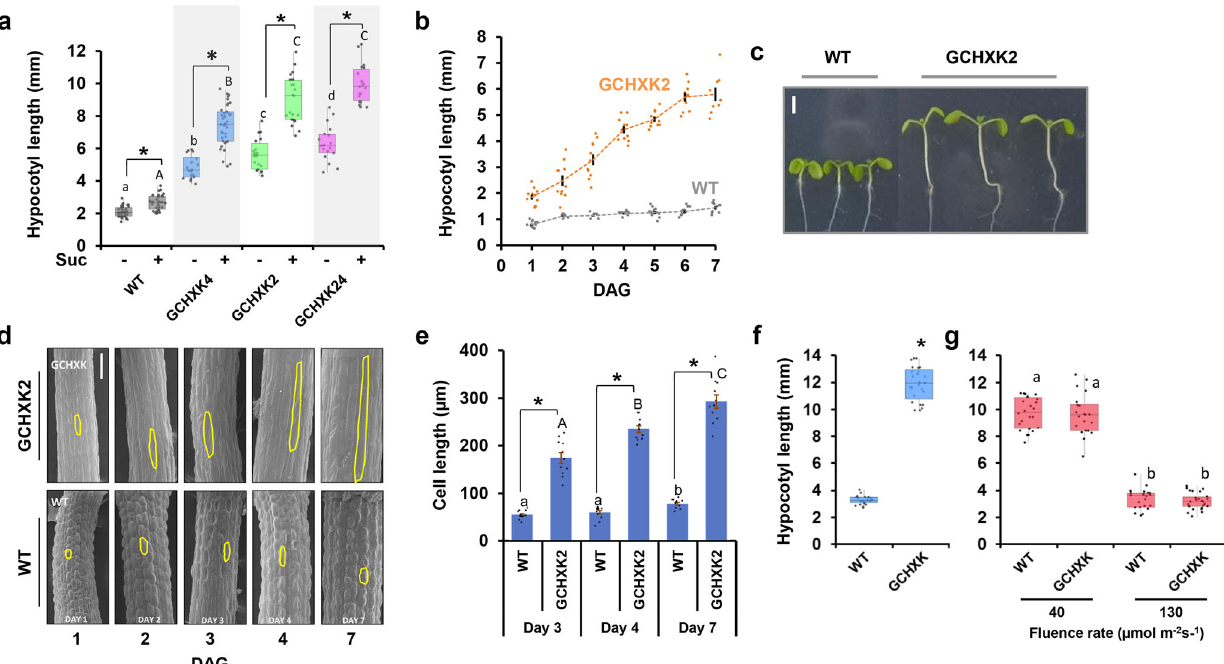
Fig. 2 Guard-cell expression of hexokinase is suf fi cient to promote hypocotyl elongation. a – g Seedlings were grown under long-day (16 h light/8 h dark, 40 μ E) conditions for 7 days on 0.5× MS agar medium. a Hypocotyl length of GCHXK seedlings grown with and without 1% sucrose. Two independent lines (GCHXK2, GCHXK4) and homozygote offspring of the cross between those two lines (GCHXK24) are shown. b Hypocotyl lengths of GCHXK2 and WT seedlings measured for 7 days after germination. Data are means ± SE ( n ≥ 7). Orange and gray dots represent individual data points for GCHXK2 and WT, respectively. c Representative images of 7-day-old WT and GCHXK2 seedlings; bar = 2 mm. d SEM images of WT and GCHXK hypocotyls taken at Days 1 – 4 and 7 following germination. Representative cell borders are highlighted, Bar = 100 µ m. e Average cell length of WT and GCHXK epidermal cells at days 3, 4, and 7 following germination. Data are means ± SE ( n ≥ 12). Gray dots represent individual data points. f , g Hypocotyl lengths of WT and GCHXK seedlings under ( f ) blue and ( g ) red light conditions with 1% sucrose. Light intensities were kept at 14 μ E for blue light and 40 or 130 μ E for red light. a , e , g Different lower-case and capital letters indicate signi fi cant differences (Tukey ’ s HSD test, P < 0.05). Asterisks indicate a signi fi cant difference relative